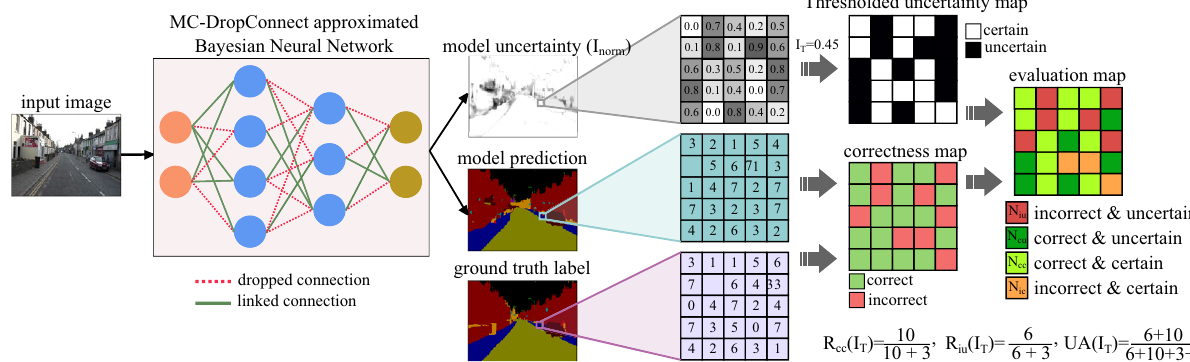
Figure 1. Overview of the proposed approximate Bayesian model (Left) and metrics to evaluate the uncertainty quality (Right) in a semantic segmentation example. Model uncertainty ( I ) is estimated as the amount of mutual information between the model parameters and the true label. I T is the uncertainty threshold which divides the prediction into certain ( I norm < I T ) and uncertain ( I norm > I T ) groups. Since segmentation is identical to pixel- wise classification, similar computations hold true for the classification